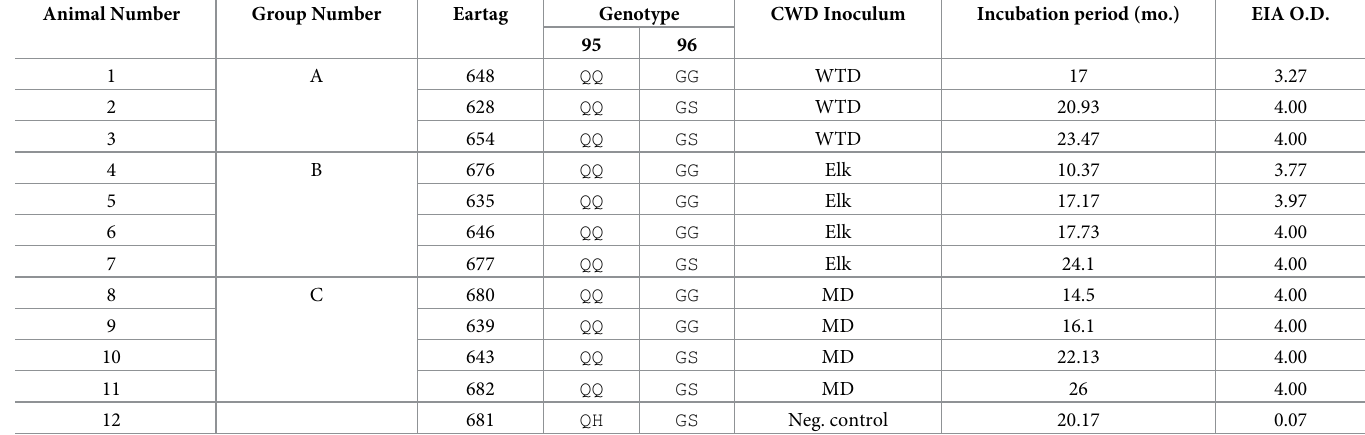
Table 1. Animal experimental summary of genotype, inoculum, survival period, and EIA in white-tailed deer inoculated intracranially with the agent of chronic wasting disease from elk, white-tailed deer and mule deer. Animal Number